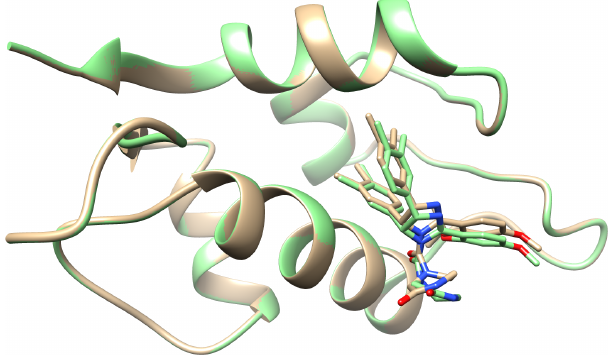
Figure A4. Ribbon representation of the protein, HDM2, with the stick representation of caylin-1 present in the binding pocket. Coloured in brown is the surface of the structure determined by traditional N MR 2 (7QDQ) by Mertens et al. (2022). Coloured in green is the structure determined by N MR 2 calculations using the diagonal-normalised approach with a precision of 10%. The nitro- gen and oxygen atoms on the ligand are coloured blue and red re-